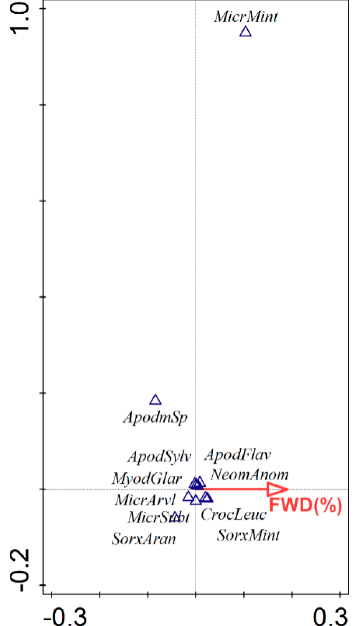
Figure 3. Partial canonical correspondence analysis biplot showing the effect of fine woody debris on small mammal species composition with the locality and successional age as a covariable. ApodFlav , Apodemus flavicollis ; ApodSylv , Apodemus sylvaticus ; MicrSubt , Microtus subterraneus ; MicrArvl , Microtus arvalis ; MicrMint , Micromys minutus ; MyodGlar , Clethrionomys glareolus ; CrocLeuc , Crocidura leucodon ; NeomAnom , Neomys anomalus ; SorxAran , Sorex araneus ; SorxMint , Sorex minutus .